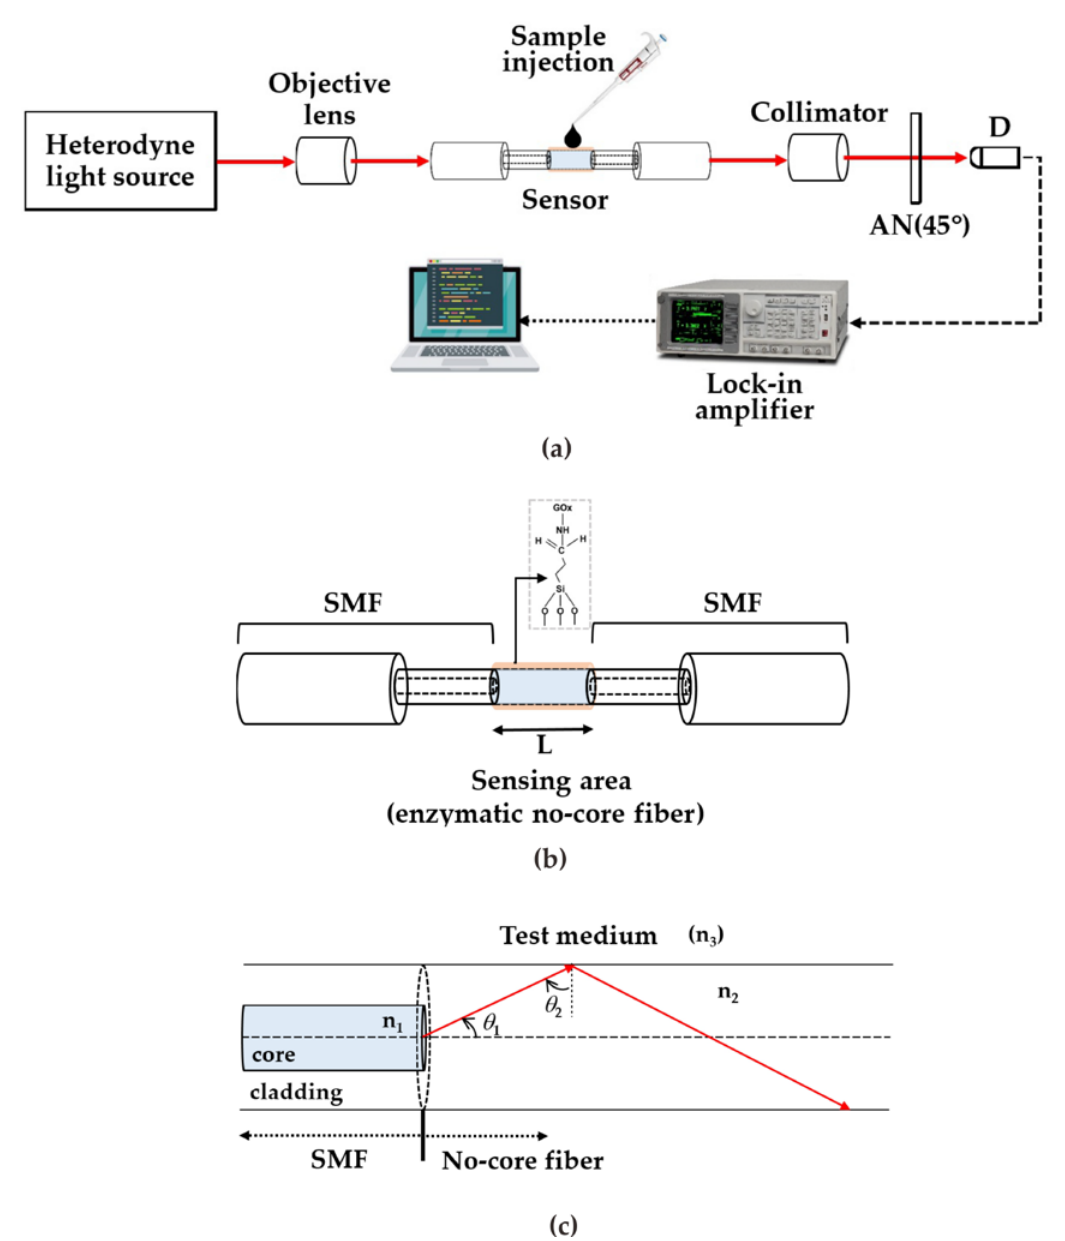
Figure 1. ( a ) Diagram of the experimental setup; ( b ) sensor structure; and ( c ) TIR phenomenon at boundary between no-core fiber and test medium.